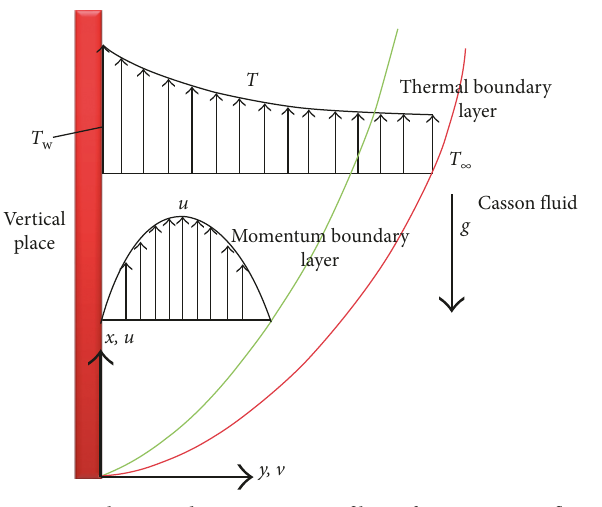
Figure 1: Velocity and temperature profiles in free convection flow over a vertical plate.